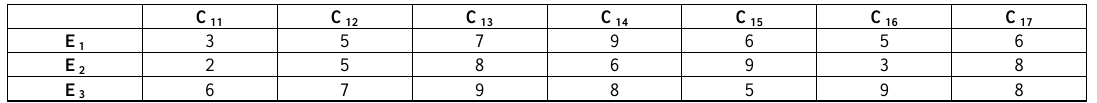
Table 5. The decision matrix for the criteria set (C 1 ).